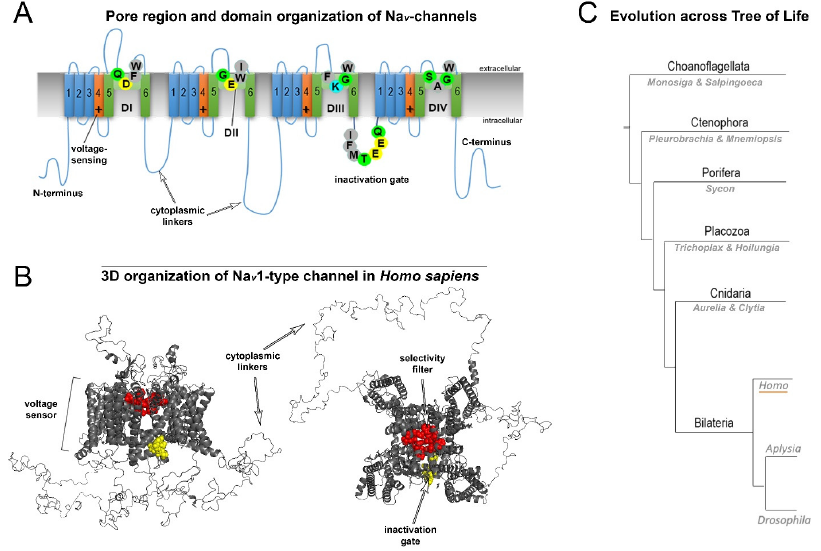
Figure 2. General structure and evolution of NaV channels. ( A ) Pore region and domain organization of NaV-channels (Homo sapiens). 2D model shows critical amino acids of NaV domains (D1-DIV), which contribute to pore selectivity motifs (marked as SF–Selectivity Filter) and inactivation gates. All species contain a critical lysine (K) in the pore region, which is responsible for sodium selectivity. Transmembrane α -helical segments are marked with numbers (1–6). Capital letters show single-letter amino acid code ( B ) 3D organization of NaV1-type channels ( H. sapiens ). The scheme includes all domains: the selectivity filter, inactivation gate and cytoplasmic linkers. ( C ) Evolution across the tree of life. Schematic phylogenetic relationships among representative animal clades of different classes of sodium channels. Homo ( humans ) , Aplysia , and Drosophila represent mammals, mollusks, and insects, respectively. Fast neuronal NaV channels (NaV1.1, NaV1.2, NaV1.3, NaV1.6) have the longest cy- toplasmic linkers. In contrast, the cytoplasmic linkers of myocyte Nav1.4 channels are the shortest. NaV1.8, NaV1.9, and NaV1.5 channels display intermediate cytoplasmic linkers (Supplementary Sequence S1). Mutations of the most well studied channels, NaV1.1, NaV1.2 and NaV1.6, are found to be associated with specific functional epileptic disor- ders. More specifically, missense mutations in the cytoplasmic linkers and N-/C-termini of those channels are often found in patients with benign epileptic syndromes, whereas mutations in transmembrane segments and D-domains in most cases are related to severe epileptic encephalopathy [6].